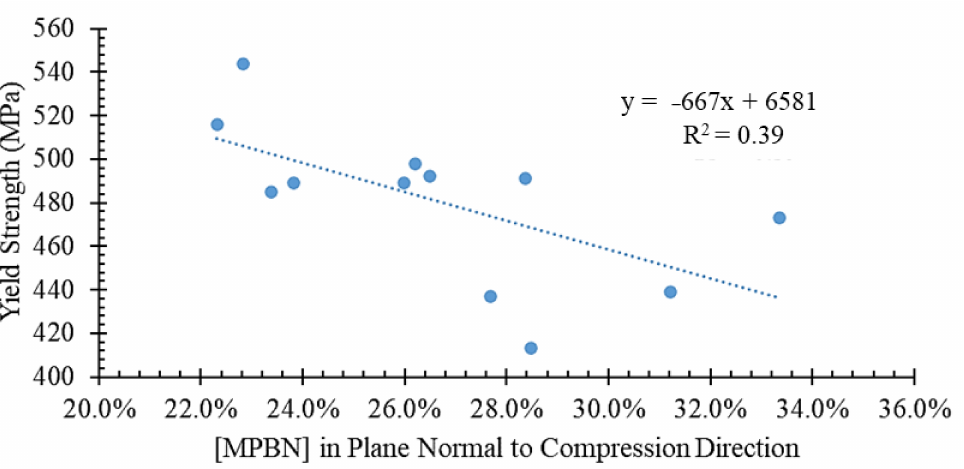
Figure 13. Plot of yield strength vs. concentration of the MPBN in the plane normal to the compres- sion